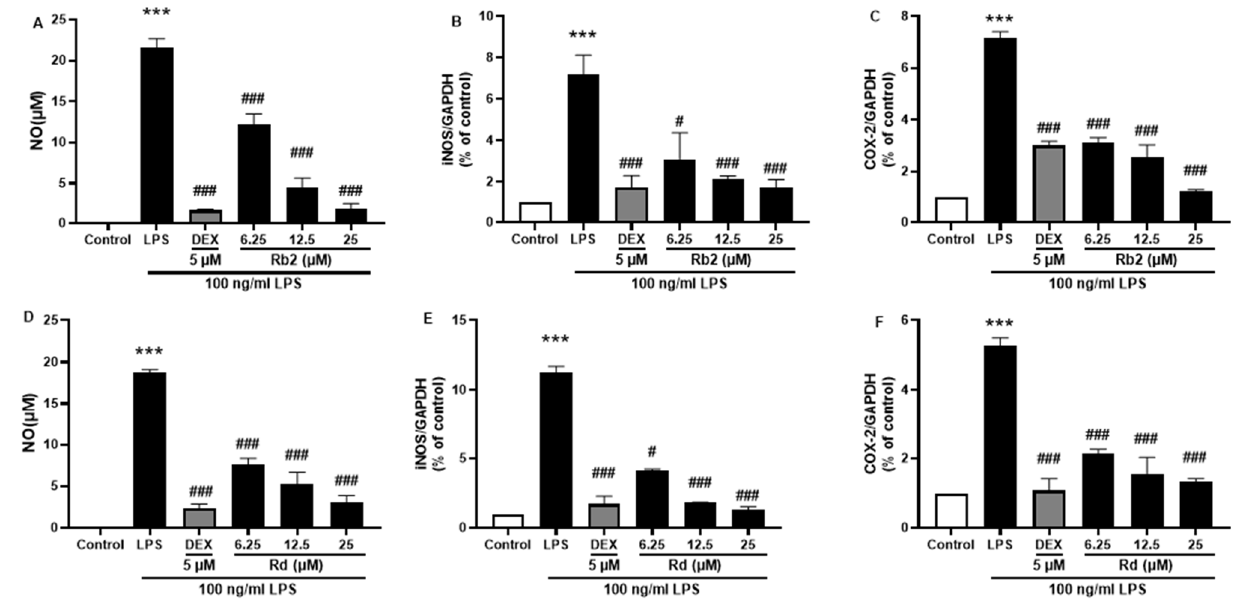
Figure 9. Effect of the ginsenoside Rb2 and Rd on nitric oxide (NO) and iNOS/COX-2 production in LPS-stimulated BV-2 cells. NO levels in the cell supernatant were measured by Griess reagent colorimetric reaction ( A , D ). Respective Western blots presenting the expression level of the iNOS ( B , E ) & COX-2 ( C , F ). Experimental results were presented as mean ± SEM. ***: p < 0.001, the significant difference compared with the control. Compared with LPS group, #: p < 0.05, ###: p < 0.001 ((one-way ANOVA followed by Dunnett’s multiple